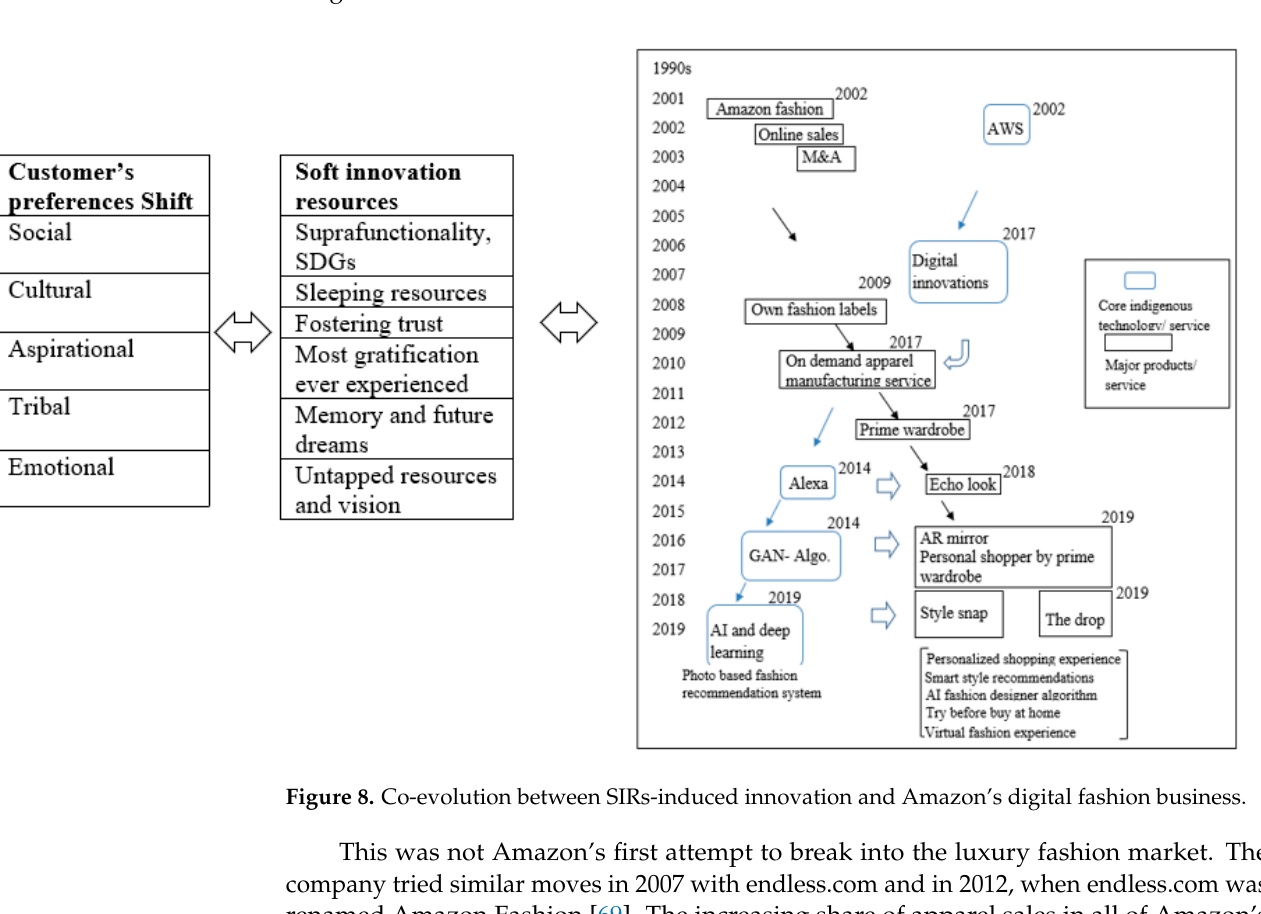
Figure 9. Trends in Amazon’s apparel sales share (2015 to 2021): percentage. Sources: [70–76].